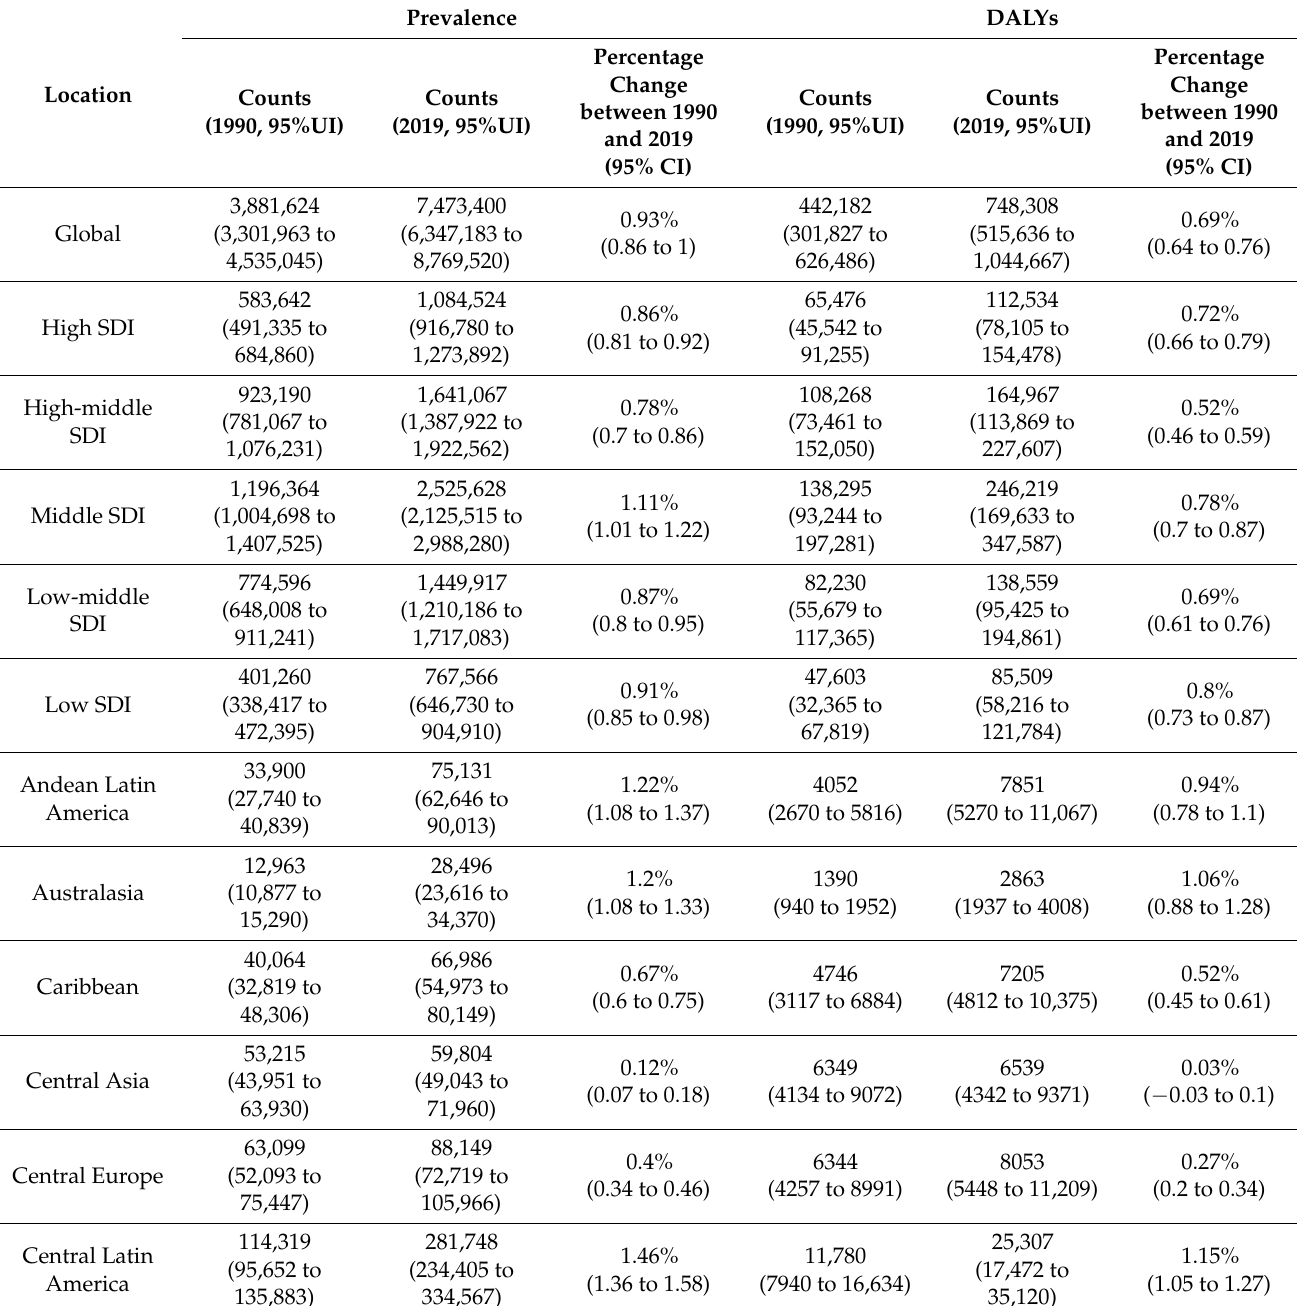
Table 1. Prevalence and disability-adjusted life-years (DALYs) of glaucoma in 1990 and 2019, with EAPC from 1990 and